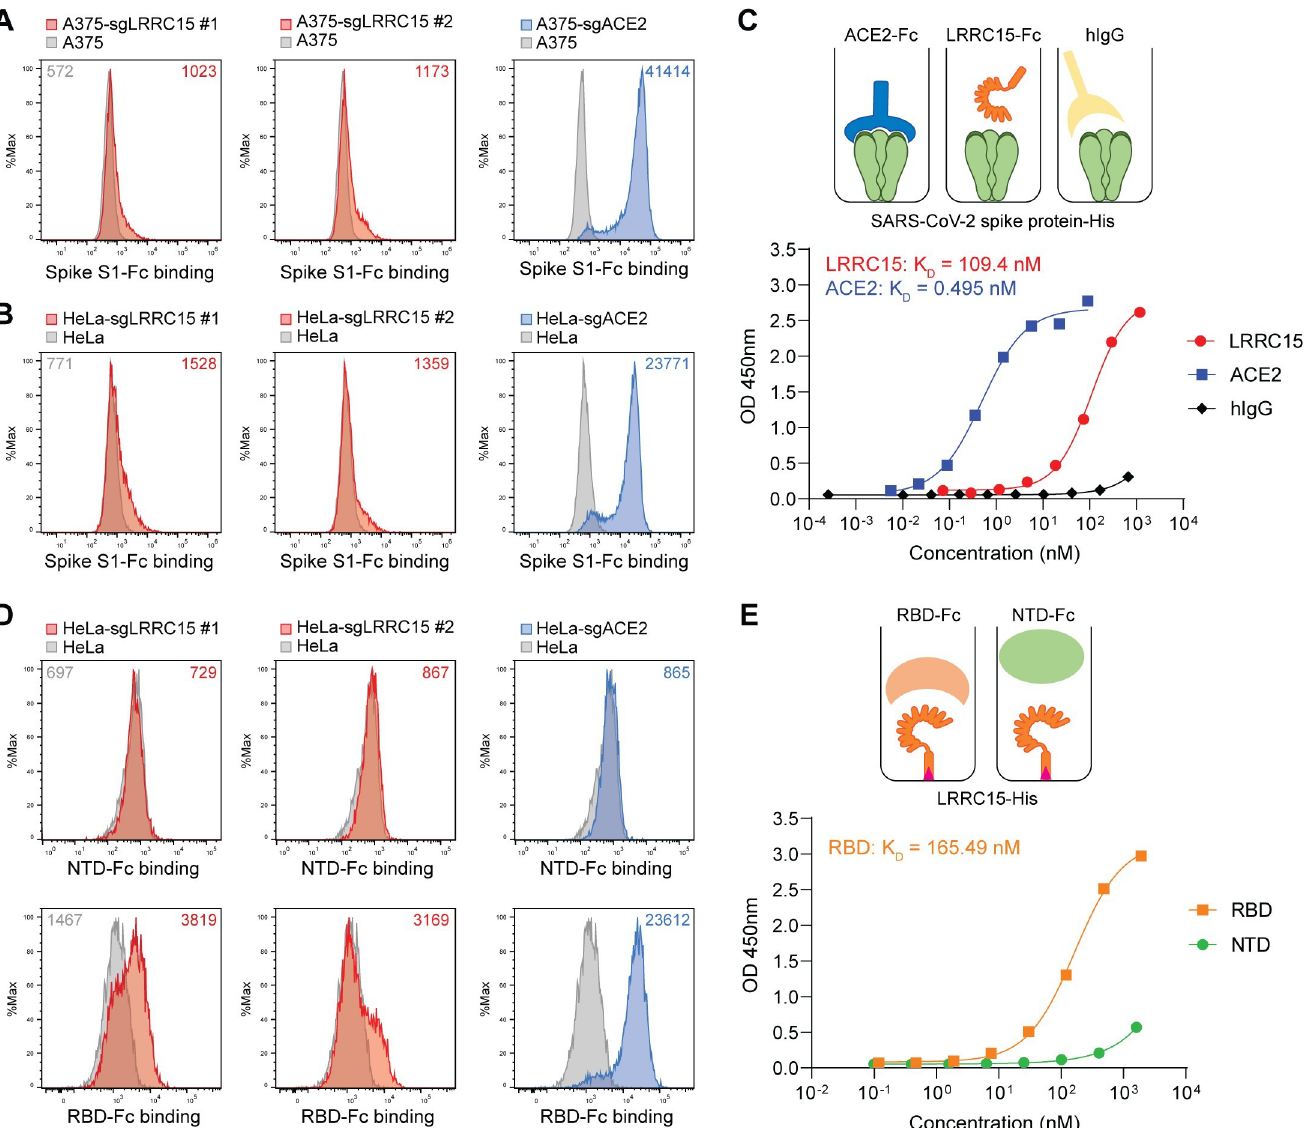
Fig 2. LRRC15 binds with SARS-CoV-2 spike protein at the RBD. ( A ) A375 cells were transduced with indicated activating sgRNAs and incubated with SARS-CoV-2 spike S1-Fc fusion protein. Protein binding was measured by flow cytometry with MFI shown. ( B ) HeLa cells were transduced with indicated activating sgRNAs and incubated with SARS-CoV-2 spike S1-Fc fusion protein. Protein binding was measured by flow cytometry with MFI shown. ( C ) Dose-dependent binding of SARS-CoV-2 spike protein (Wuhan-Hu-1) to both ACE2 and LRRC15 with an Fc tag was determined by ELISA. Human IgG1 was included as a negative control. Dots indicate means of duplicates. ( D ) HeLa cells were transduced with indicated activating sgRNAs and incubated with SARS-CoV-2 spike NTD-Fc or RBD-Fc fusion protein. Protein binding was measured by flow cytometry with MFI shown. ( E ) The binding of the SARS-CoV-2 RBD and NTD to LRRC15 was measured by ELISA. For underlying data, see S3 Data . ACE2, angiotensin-converting enzyme 2; LRRC15, leucin-rich repeat-containing 15; MFI, mean fluorescence intensity; NTD, N-terminal domain; RBD, receptor-binding domain; SARS-CoV-2, Severe Acute Respiratory Syndrome Coronavirus 2; sgRNA, single guide RNA.